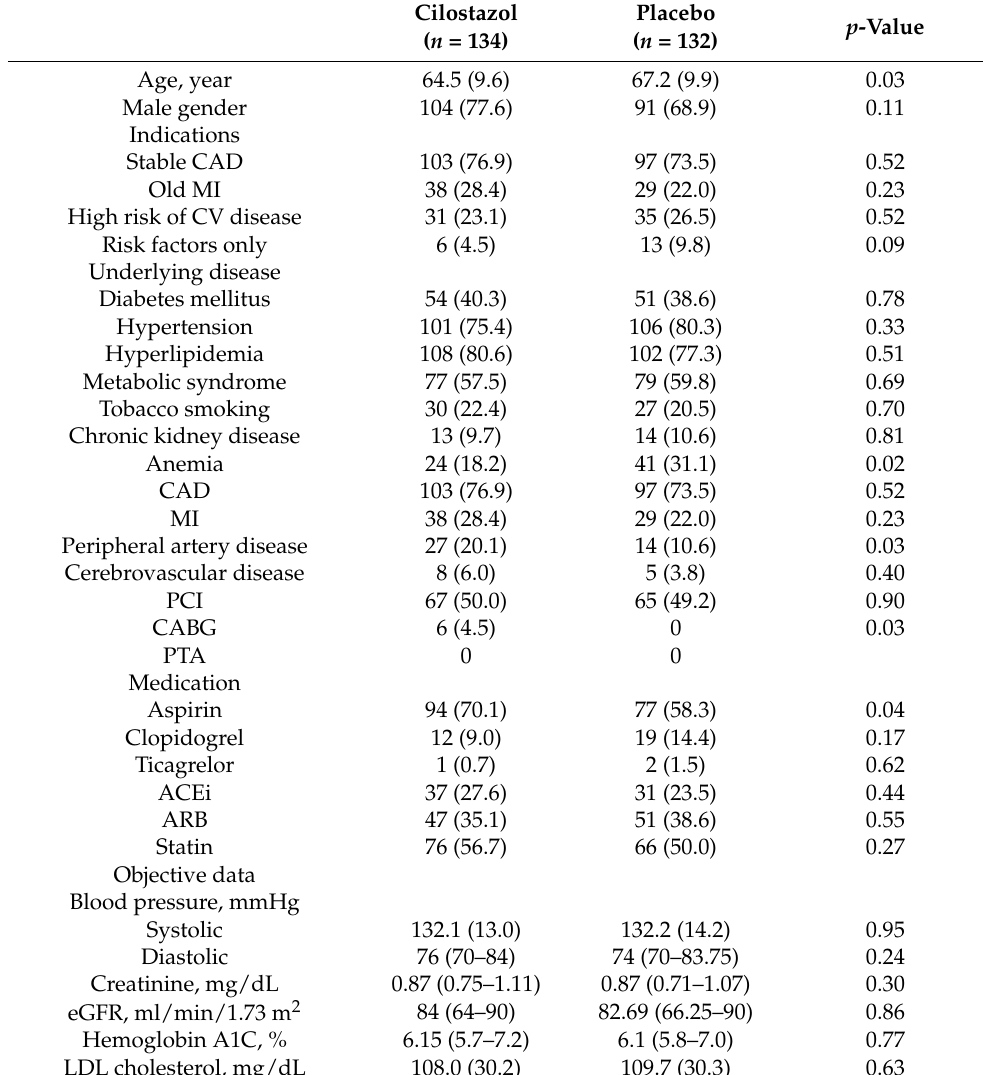
Table 1. Comparisons of the baseline characteristics between participants assigned to cilostazol and